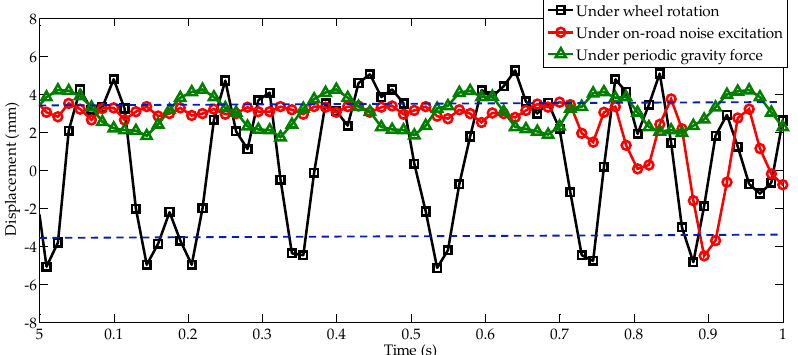
Figure 11. Displacement responses under three conditions: (1) on-road noise excitation; (2) periodic gravity force; and (3) wheel rotation combined with the on-road noise excitation and the periodic gravity force.